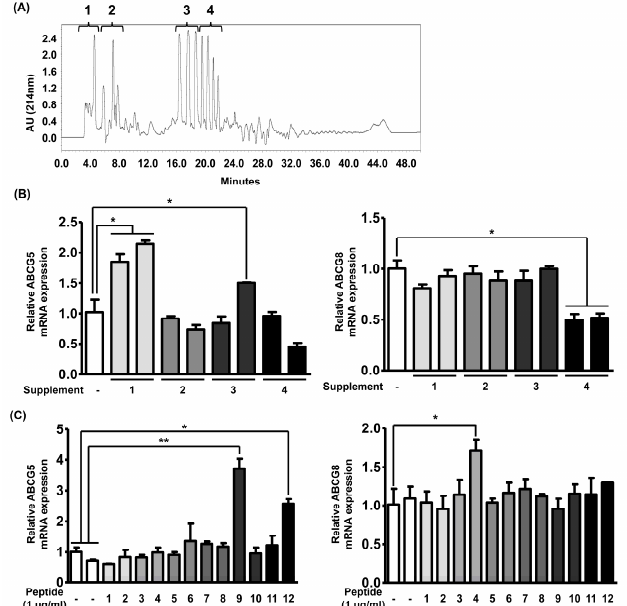
Figure 2. TICE is induced by bioactive peptide in casein hydrolysates. ( A ) A graph showing results of